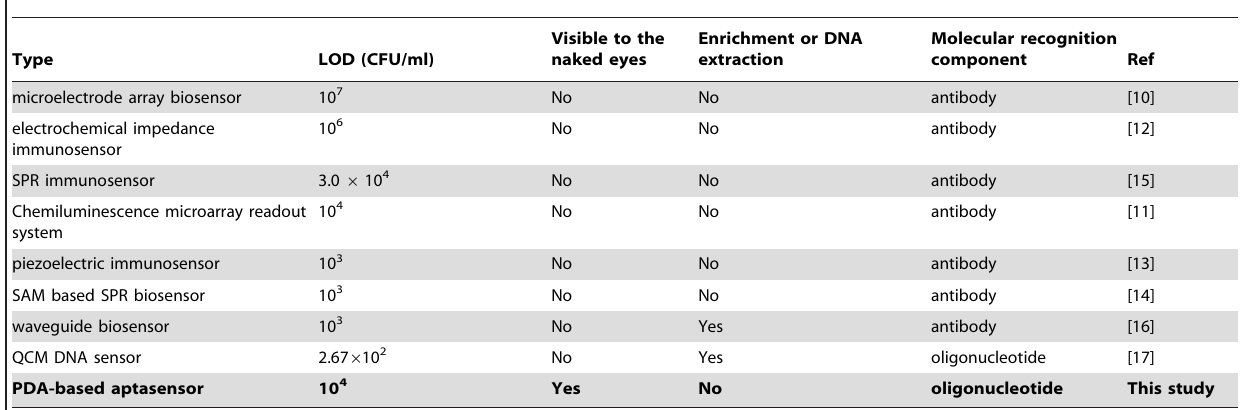
Table 1. Performance comparison between biosensors for the Detection of E. coli O157:H7.